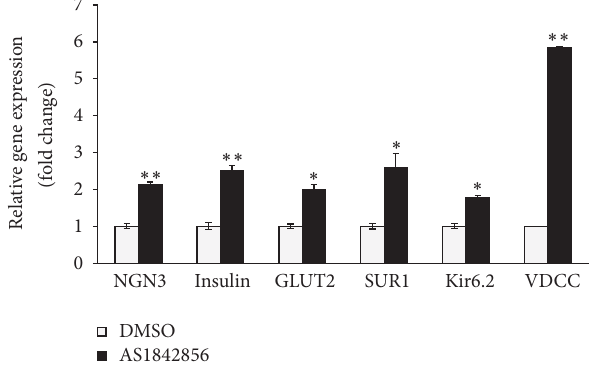
Figure 4: FoxO1 inhibitor increased mRNA expression of 𝛽 cell markers. Human fetal pancreatic progenitor cells were treated with DMSO or AS1842856 for 3 days. qRT-PCR analysis of 𝛽 cell markers. Data were expressed as fold change relative to DMSO group and are means ± SEM of 4 independent experiments per each group. ∗ or ∗∗ , 𝑝 < 0.05 or